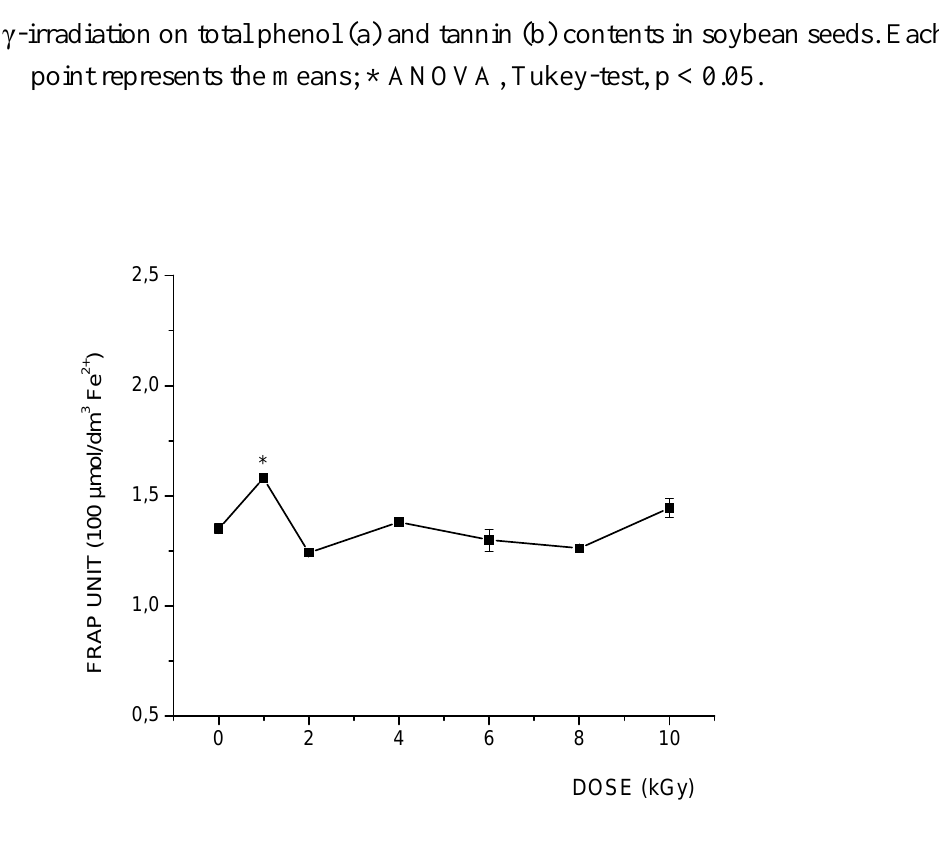
Figure 4. Effect γ -irradiation on total antioxidant activity determined by FRAP method in soybean seeds. Each data point represents the means; * ANOVA, Tukey-test, p < 0.05. Total antioxidant activity determined by FRAP method was significantly increased at doses of 1 kGy (17.0 %); the increase was insignificant at 4 kGy (2.2 %) and 10 kGy (6.7 %) (Figure 4). The irradiation induced increase in total antioxidant activity at dose of 1 and 10 kGy could be the result